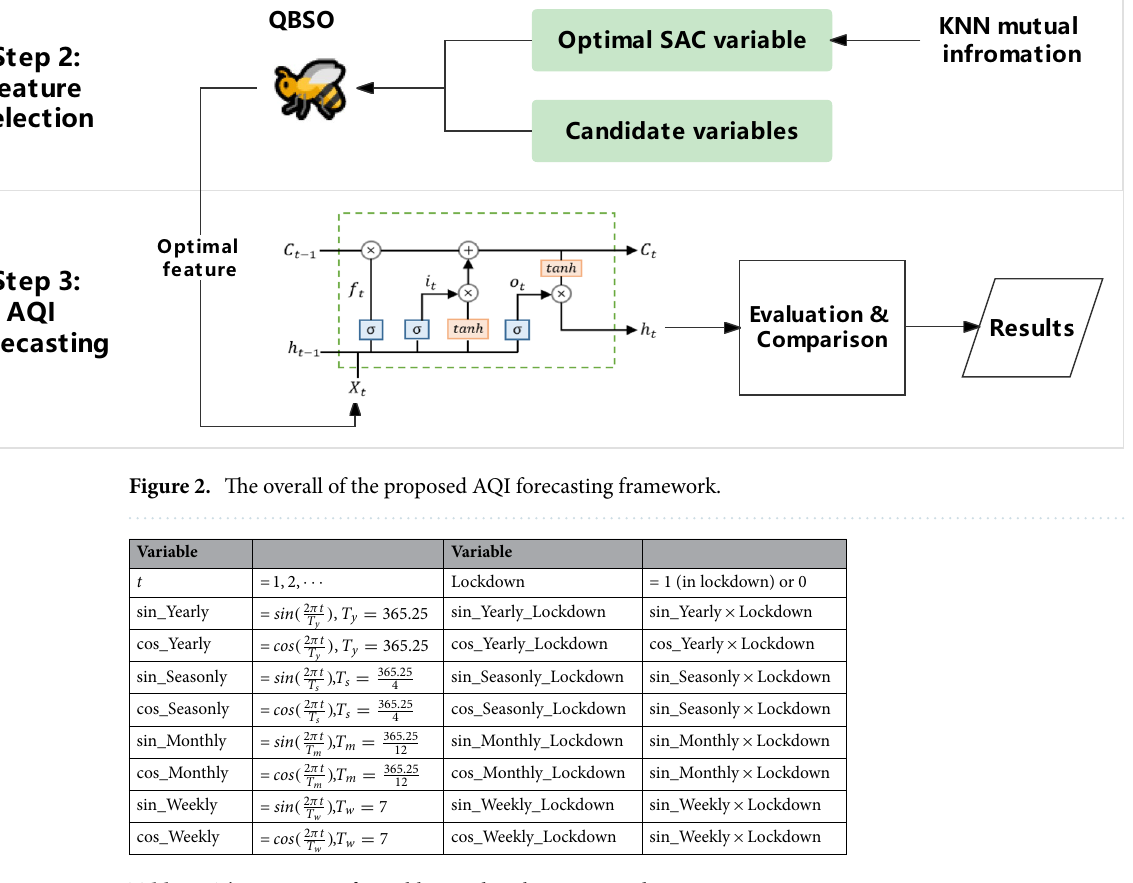
Table 1. The meaning of variables used in the COVID